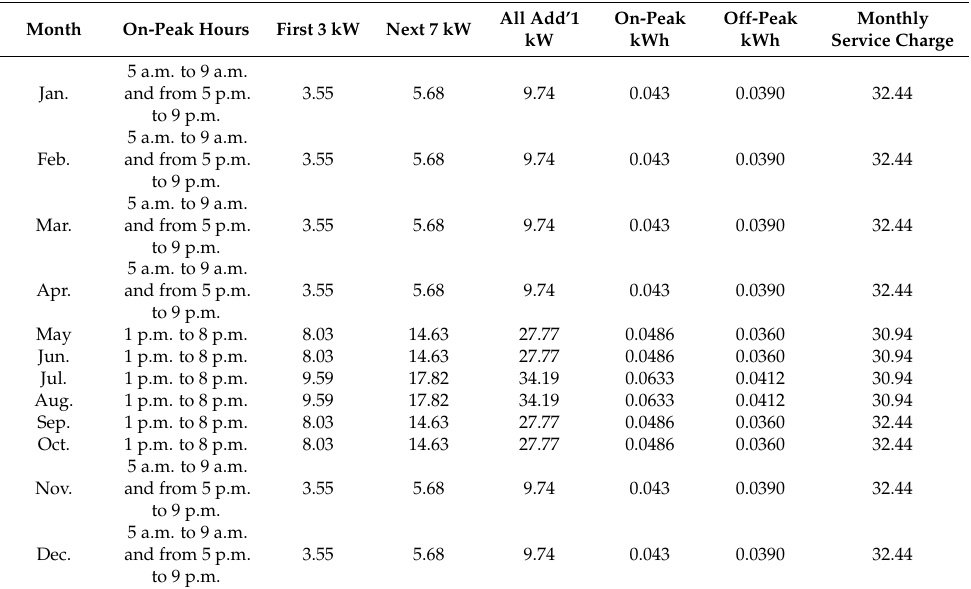
Table 2. Price plan for the state A.